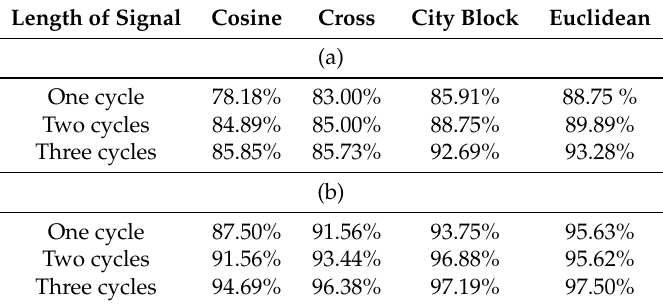
Figure 7. Example of ECG pattern from three different individuals (signals from the same individual are collected from the same recording session and they are closely overlapped): ( a ) one heartbeat; ( b ) two heartbeats. Different color lines show about different individuals. Table 2. Identification rates with the four different pattern matching methods using wrist ECG data: (a) for 55 subjects; (b) for the reduced number of 20